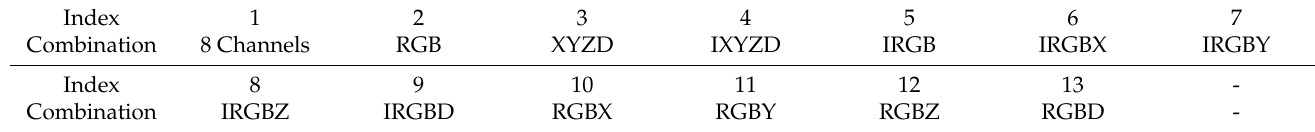
Table 2. Combinations of